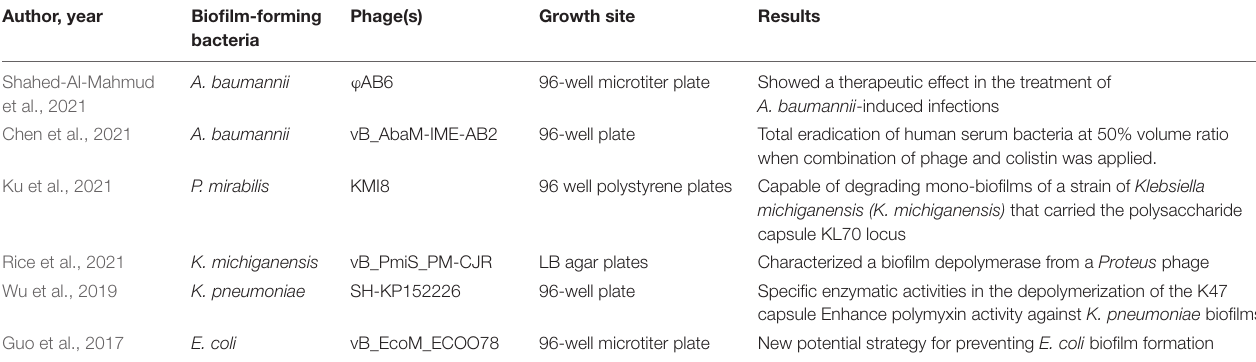
TABLE 3 | Anti-biofilm depolymerase